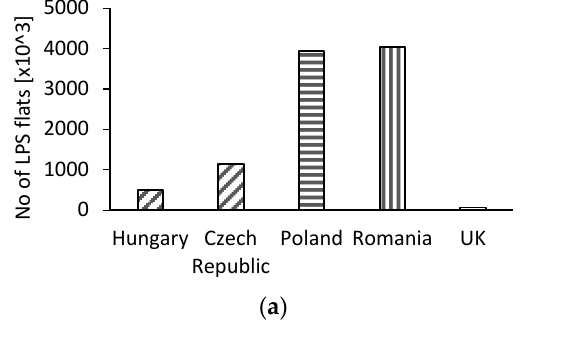
Figure 4. Contribution of LPS flats: ( a ) in selected EU countries ( b ) in Poland in years 1946–1992 (based on the information provided in [18,19]).